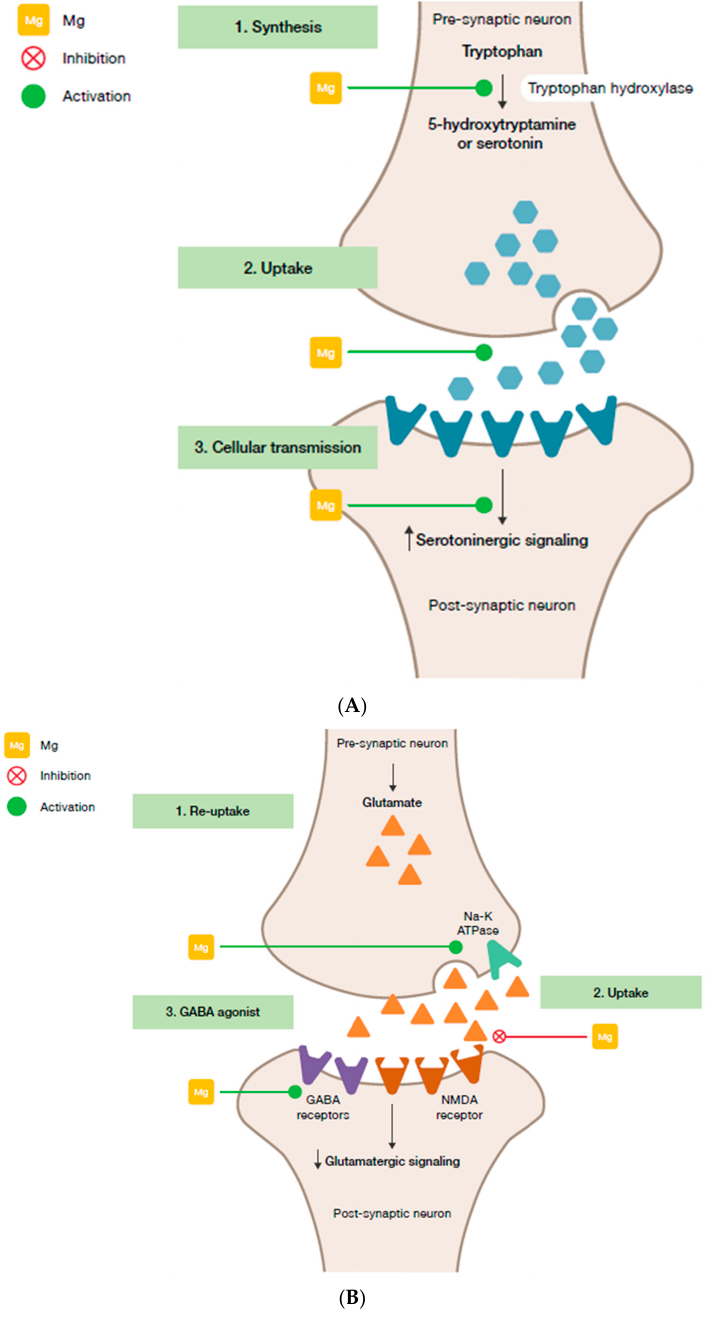
Figure 2. Interaction of magnesium and neurological stress mediators. ( A ) Serotoninergic transmission. ( B ) Glutamatergic and GABAergic transmission. GABA, γ -aminobutyric acid; Mg, magnesium; NMDA, N-methyl-D-aspartate.